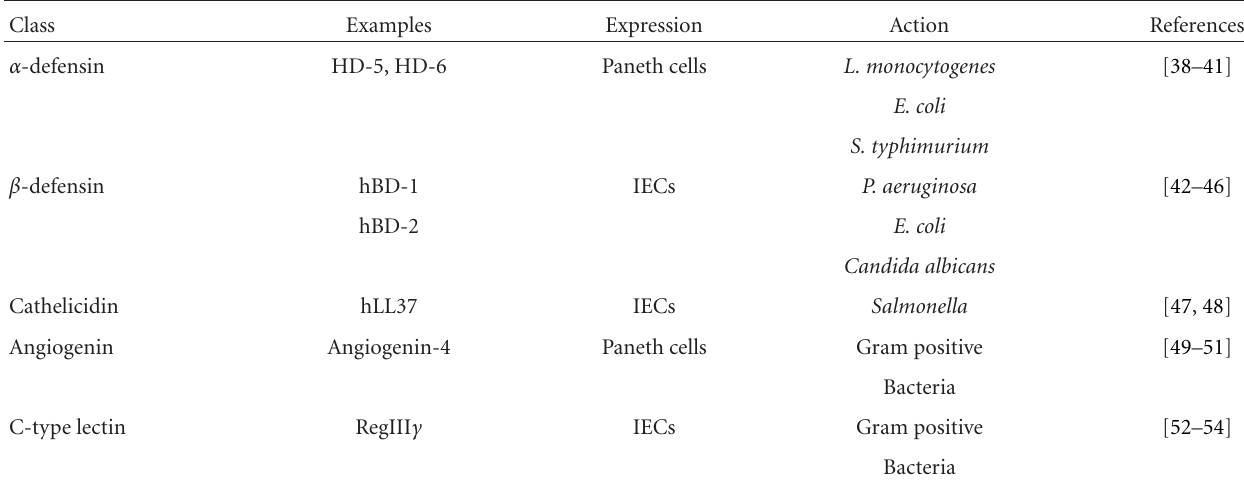
Table 1: Antimicrobial peptides/proteins and their